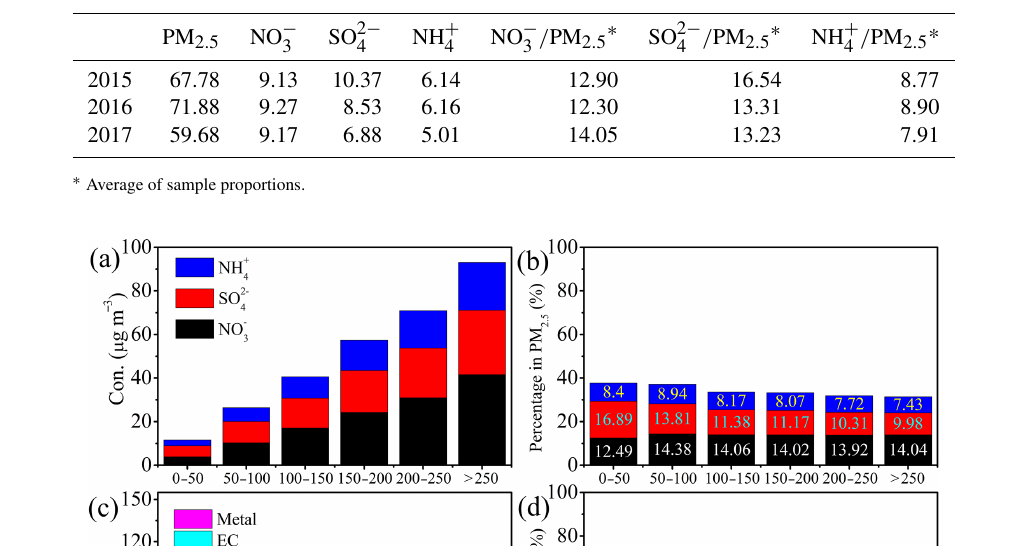
Table 2. Comparison of annual mass averages (µgm − 3 ) and proportions (%) for NSA (nitrate, sulfate and ammonium) from 2015 to 2017.